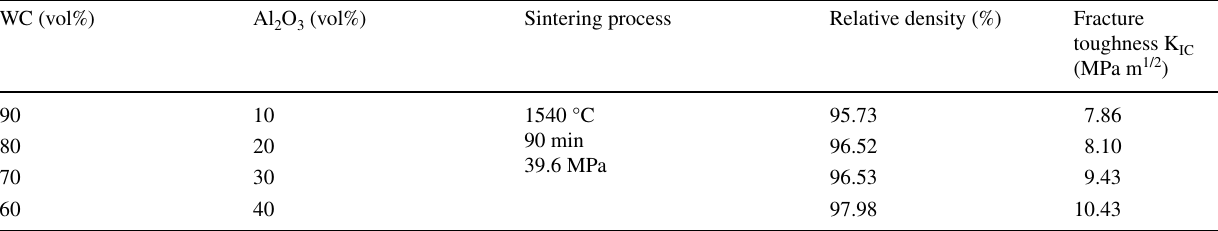
Table 5 Composition proportion, relative density and fracture toughness of WC–Al 2 O 3 composites [101] WC (vol%) Al 2 O 3